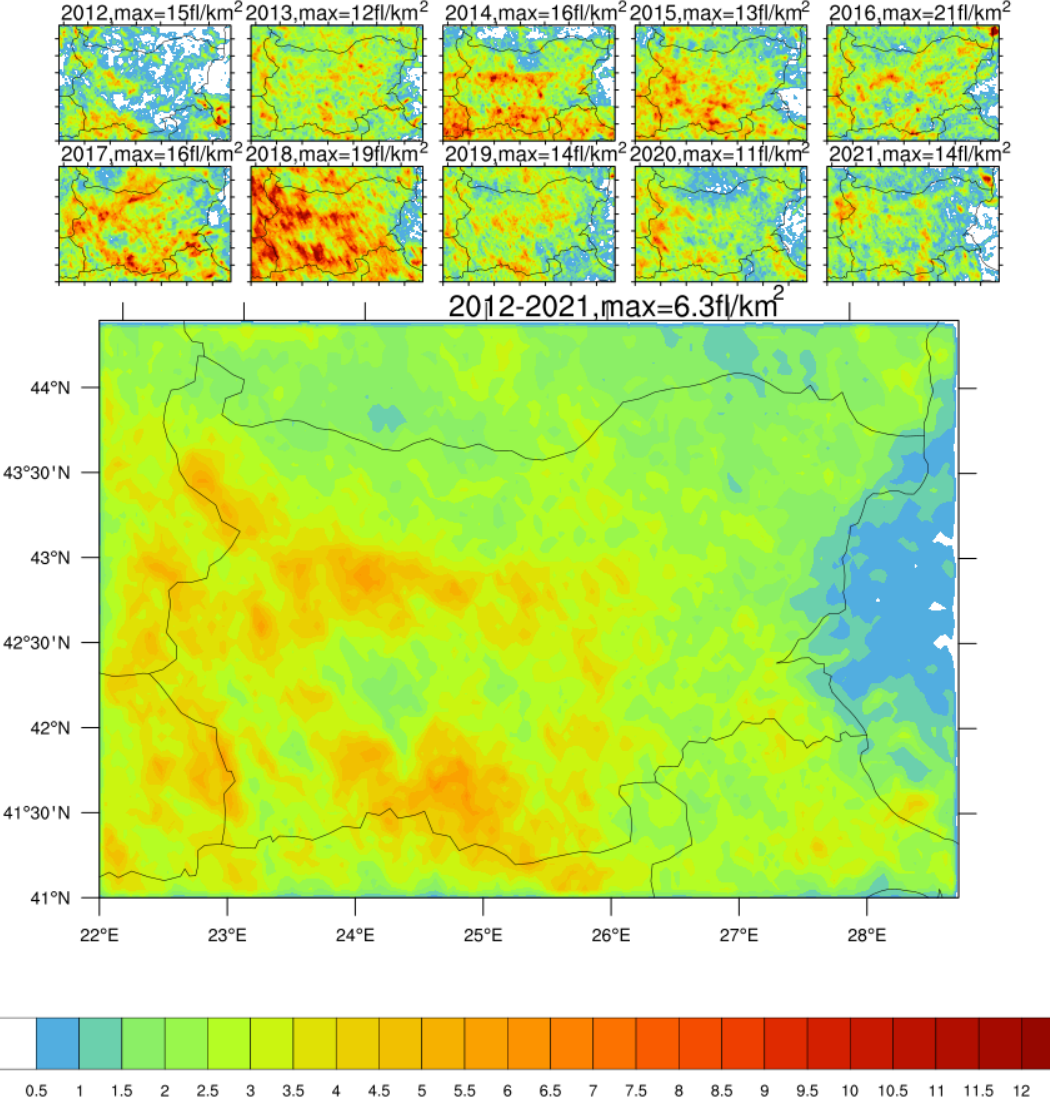
Figure 9. Annual spatial (on a grid of 0.05 × 0.05 deg) distribution of flash density (number of flashes per km 2 per year), according to ATDnet during 2012, 2013, 2014, 2015, 2016, 2017, 2018, 2019, 2020, and 2021, and the yearly average for the whole period 2012 – 2021.